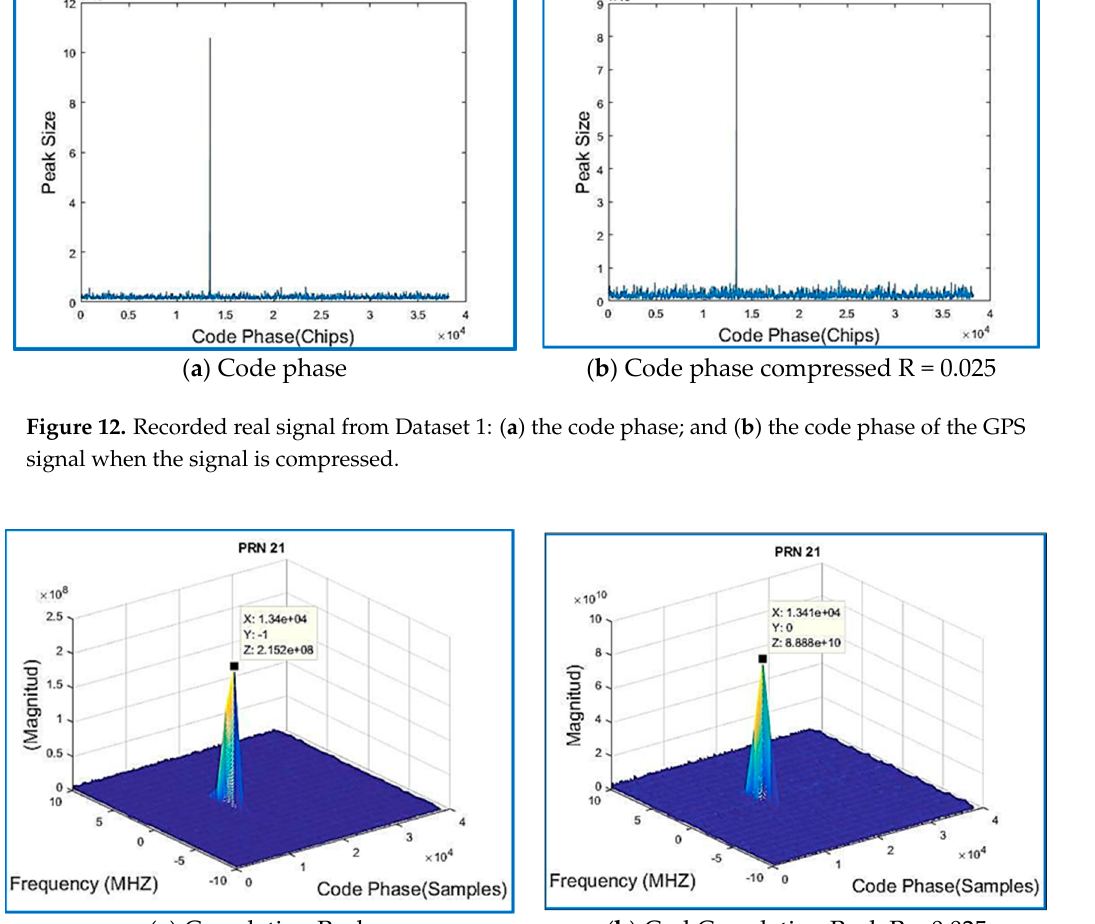
Figure 13. Recorded real signal from Dataset 1: ( a ) the correlation peak; and ( b ) the correlation peak of the regular GPS signal compressed for the same Dataset 1.